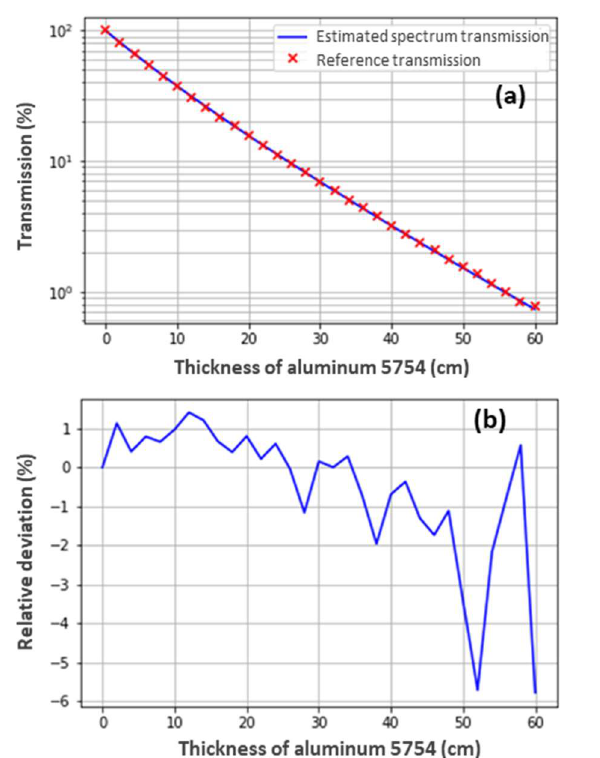
Fig. 12. (a): Experimental transmission values (red dots) and estimated spectrum transmission curve (blue) - (b): Relative differences between experimental and estimated values as a function of